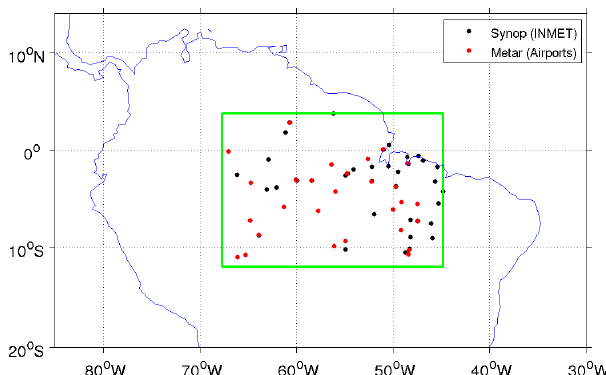
Figure 10. Locations of surface meteorological stations for model